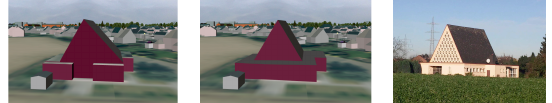
Figure 18: A church with simple roof structure: model-driven (left) and data-driven approach (right). The model-driven ap- proach leads to a wrong roof facet to the